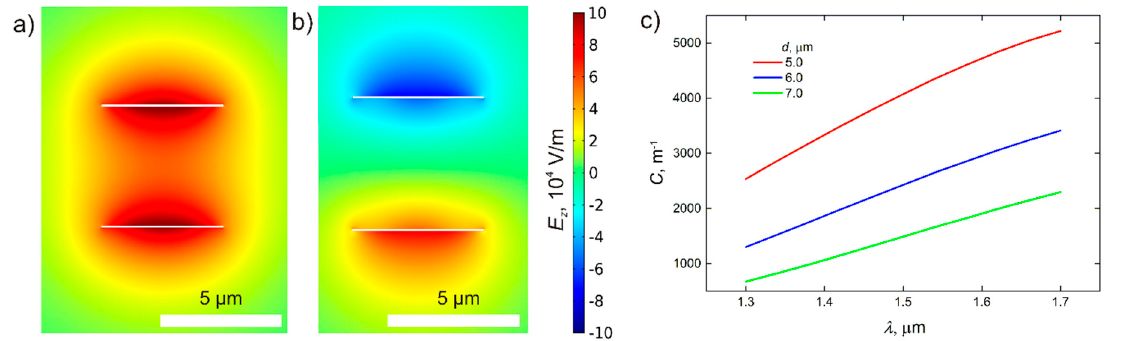
Figure 4. ( a , b ) Distribution of the z -component of the field in modes of the system consists of two coupled plasmonic strip waveguides. Transverse electric field distributions for two eigenmodes (perturbed S-mode of the separated waveguide in the presence of the second waveguide) of the system of coupled plasmonic waveguides with thickness t = 40 nm (scale bar, 5 μ m). ( c ) The difference between these modes characterizes the energy transfer between waveguides. The dependence of coupling constant on wavelength for strip waveguides with the different distances between them.